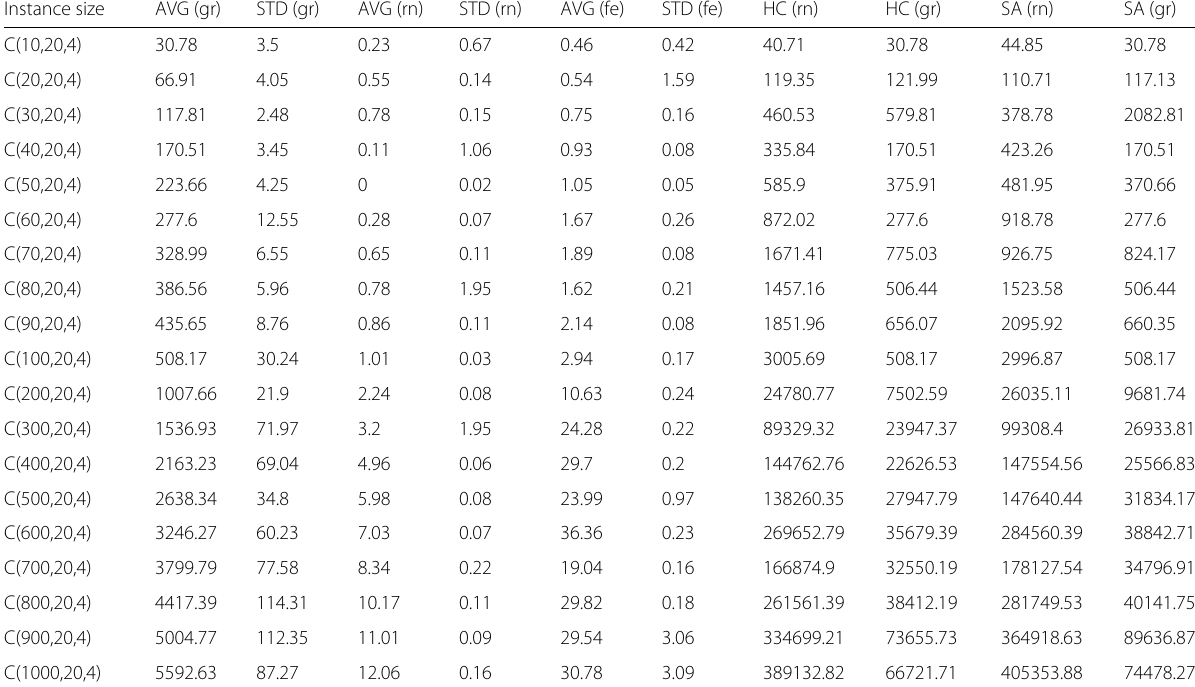
Table 11 Computational Effort of different instant